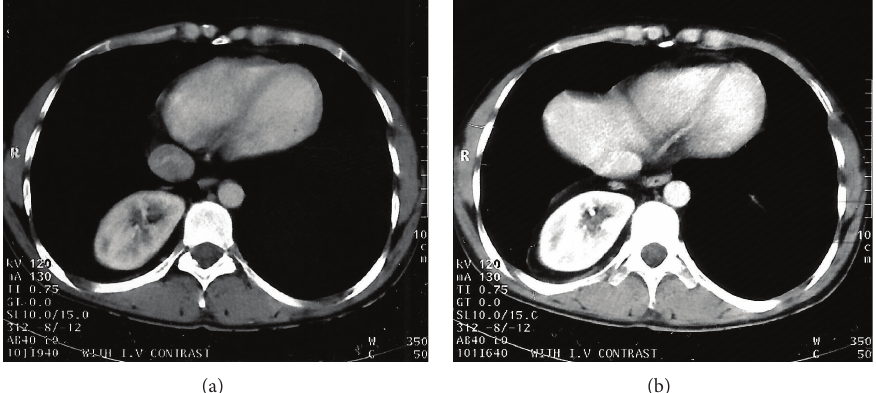
Figure 3: 32-year-old man with thoracic ectopic kidney; an axial contrast enhanced CT scan of the revealed right kidney is in the lower portion of the right